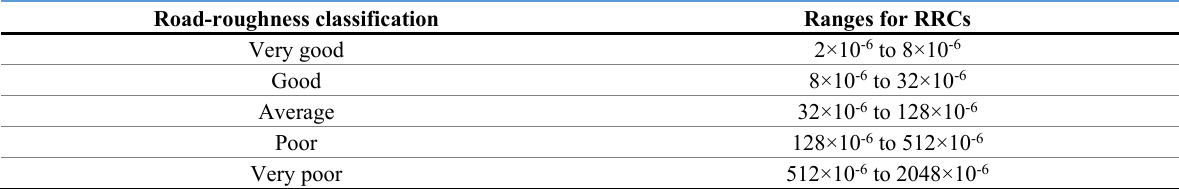
Table 3. RRC Values for road-roughness classification [18].